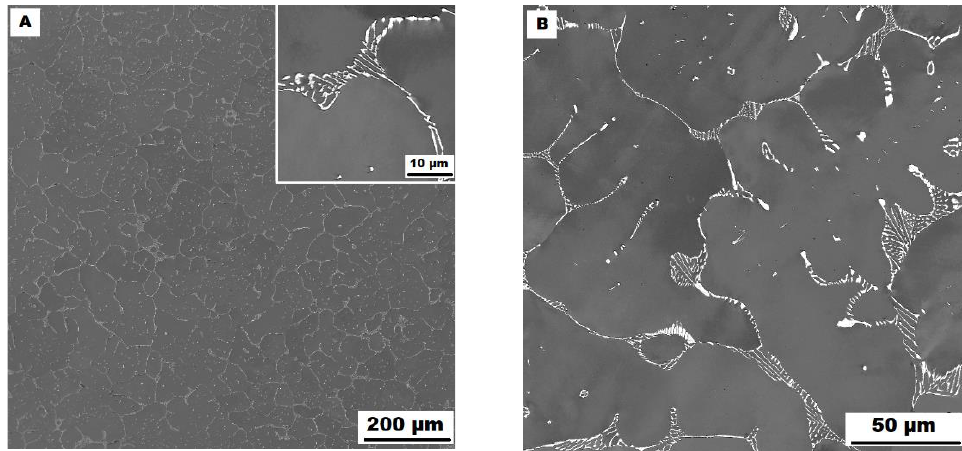
Figure 5. The structure of Fe – 28Al – 5Si – 2Mo – 1B alloy in the as-cast state (SEM, 10 kV, BSE). ( A) overview of the structure, ( B ) detail of the structure